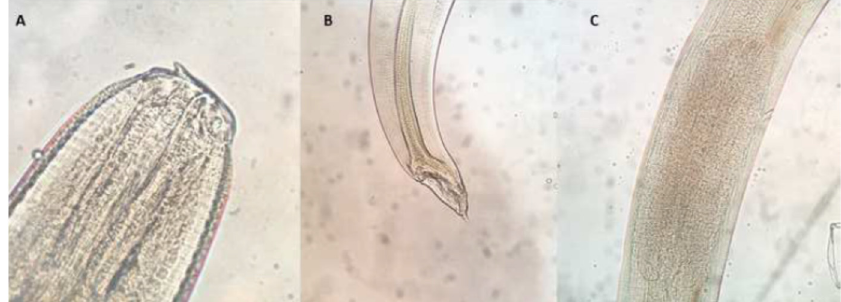
Figure 3. Anterior ( A ), posterior ( B ) and ventricular ( C ) region of an Anisakis spp. L3.